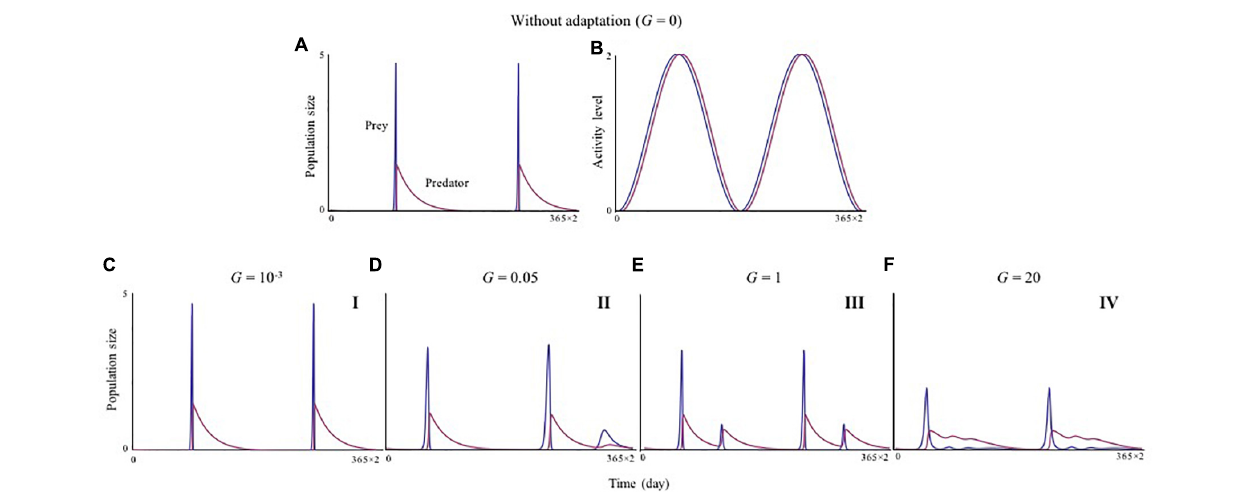
FIGURE 1 | The speed of adaptation changes predator–prey dynamics. Dynamics of population sizes (A) and activity cycles (B) without adaptation. (C–F) Dynamics of population sizes in relation to the speed of adaptation. G X = G Y = G is assumed. Faster adaptation (increasing G ) tends to decrease the amplitudes of population cycles. (A,B) G = 0; (C) G = 0.001; (D) G = 0.05; (E) G = 1; and (F) G = 20. I–IV represent the patterns shown in different phases (see Figures 2 , 3 ). Initial values X (0), Y (0), U X (0), and U Y (0) are 0.1, 0.1, 10/365, and 20/365, respectively. Parameters are Z 0 = 2, a 0 i = 0.5, ε = 0.1, g i = 0.2, d i = 0.01, c 0 i = 0.01, θ i = 0.001, ¯ U ¯ U X = 10/365, and Y = 20/365. The time range shown on the horizontal axis is from 5 × 10 5 –2 T to 5 × 10 5 (for convenience, the initial time is notated as 0).